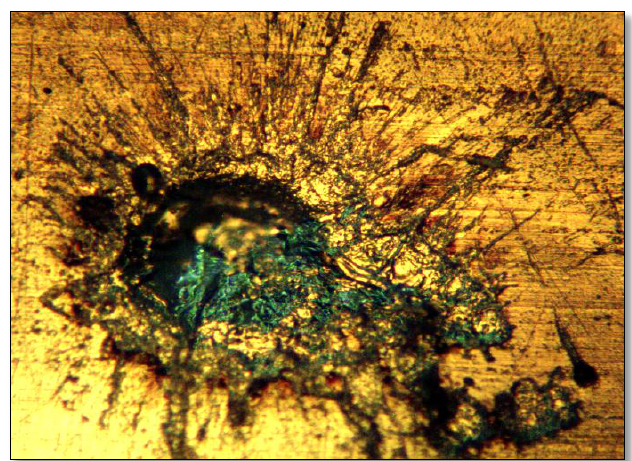
Fig.7: Laser drilling of copper foil by single laser pulse,